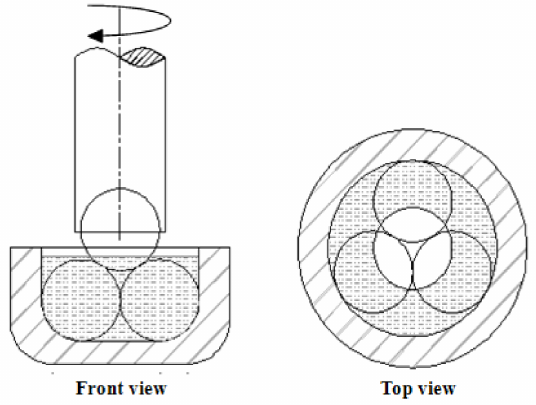
Figure 1. Schematic of the four-ball rolling